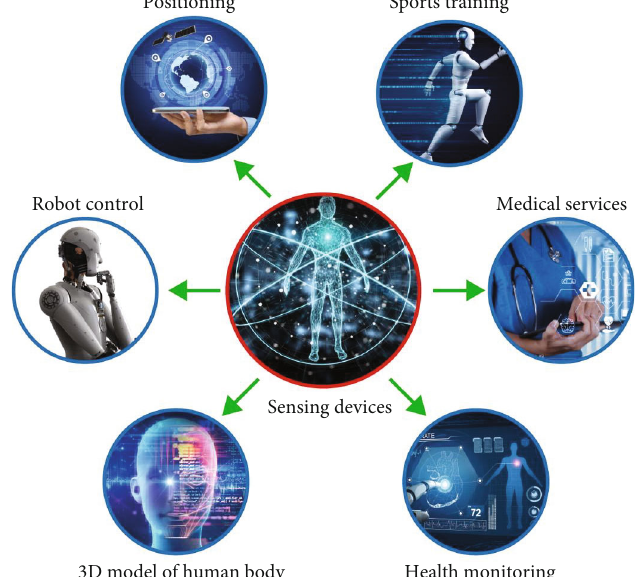
Figure 1: Application scenario of motion capture